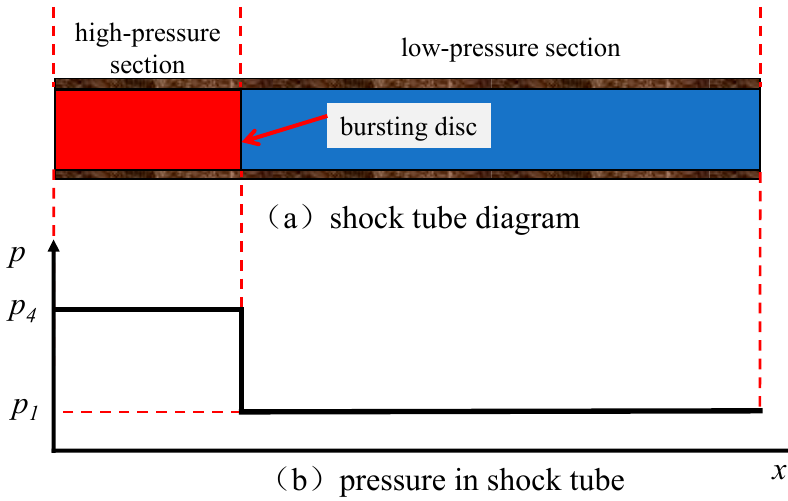
Figure 4. Initial state of the shock tube. In the shock tube experiment, when the pressure difference on both sides of the bursting disc exceeds its critical value, the bursting disc ruptures. Due to the huge pressure difference on the two sides of the bursting disc, an incident shock wave is generated from the bursting disc position to the right side, and a sparse wave is generated to the left side, as shown in Figure 5. In order to facilitate the later description, the original high-pressure section of the shock tube is called zone 4, and the low-pressure section is called zone 1. When the incident shock wave is formed, its power is the high-pressure gas on the left side, but after the incident shock wave begins to move, it begins to cause a sudden change in the parameters of the low-pressure section at the junction with it. The shock wave front is transferred to the original low-pressure section gas, and the gas parameters (including pressure) of the low-pressure section of this part are surged to form zone 2. With the passage of time, zone 2 gradually moves to zone 1, and the moving speed is the shock wave front speed. The influence range of the sparse wave moving to the left is called zone 3, and the gas parameters (including pressure) in zone 3 become smaller. One difference between rarefaction waves and shock waves is that rarefaction waves do not cause sudden changes in gas parameters, so rarefaction waves are generally not ignored as a line in the vertical direction in space. However, the spatial length of the sparse wave is very short compared with zone 3, and they are all formed by the original high-pressure gas, so this zone is merged into zone 3 and its parameters are regarded as zone 3. Therefore, after the rupture of the bursting disc, the shock tube is divided into zone 4, zone 3, zone 2 and zone 1 from left to right. The pressure in zone 4 is the largest, the pressure in zone 1 is the smallest, zone 3 and zone 2 are equal and between zone 4 and zone 1. Before the incident shock wave or rarefaction wave reaches the two ends of the shock tube, the range of zone 2 and zone 3 gradually increases, and the range of zone 1 and zone 4 gradually decreases.